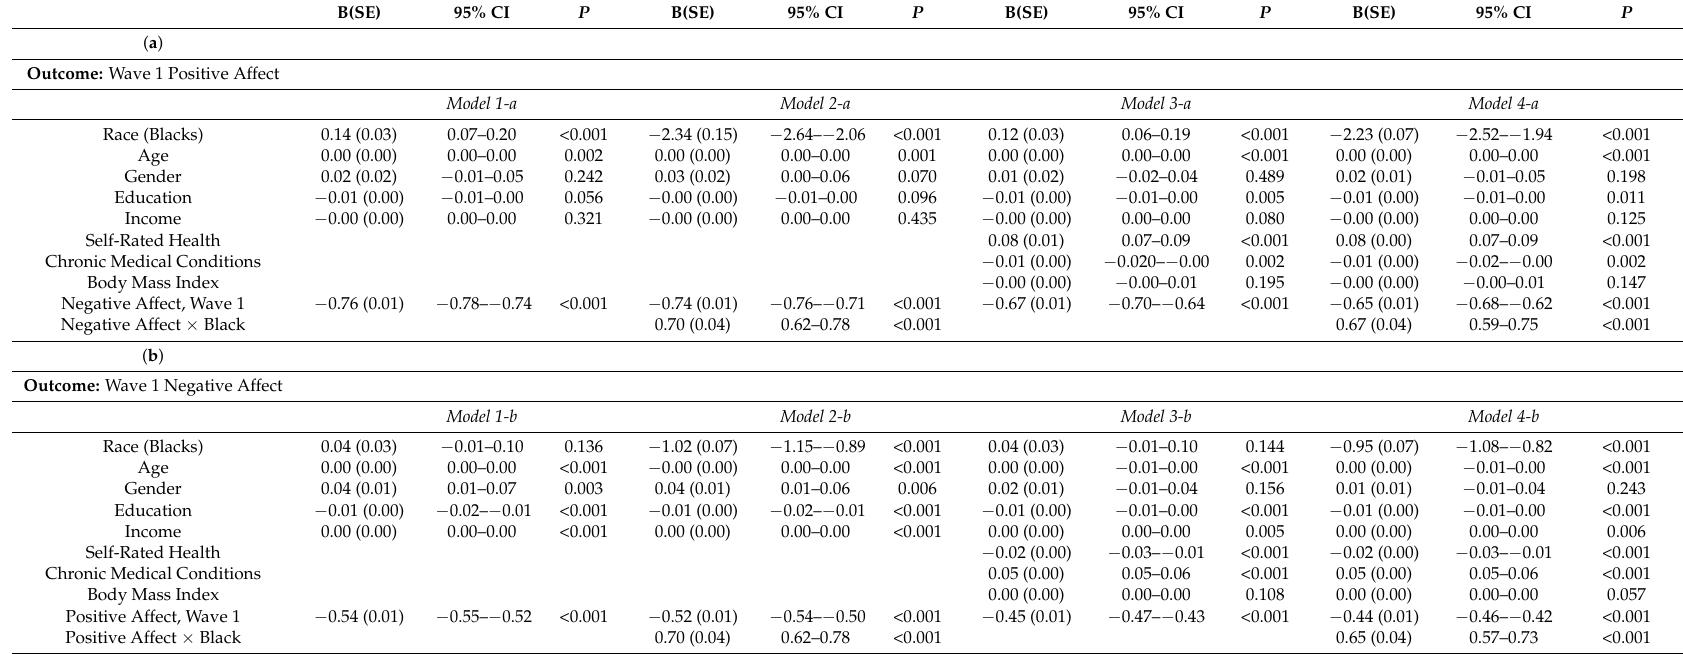
Table 3. Predictors of wave 1 positive and negative affect in the pooled